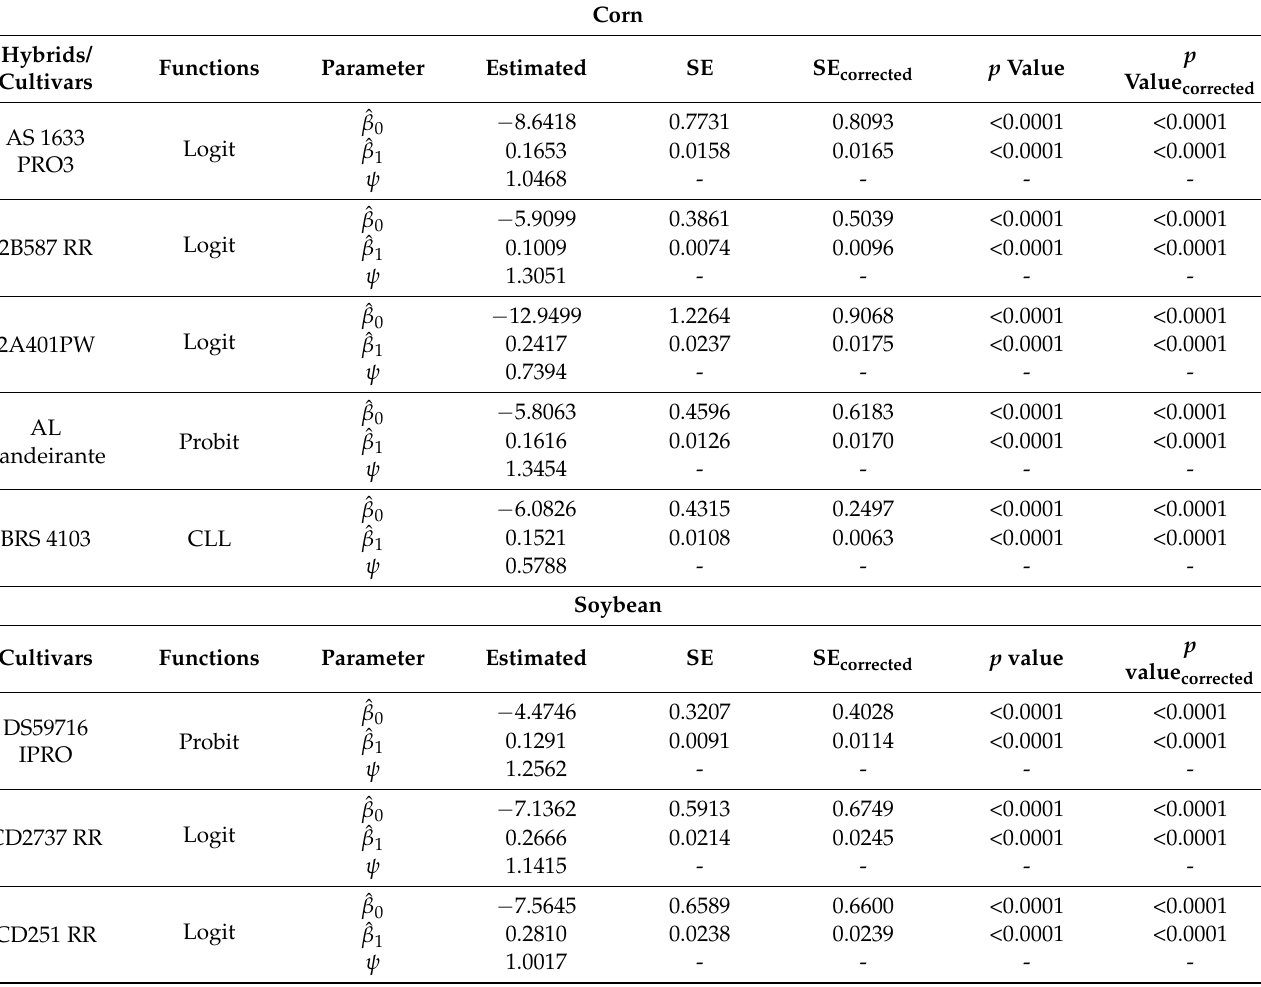
Table 4. Estimation of the parameters of the binomial regression models adjusted to the proportion data in the germination of corn and